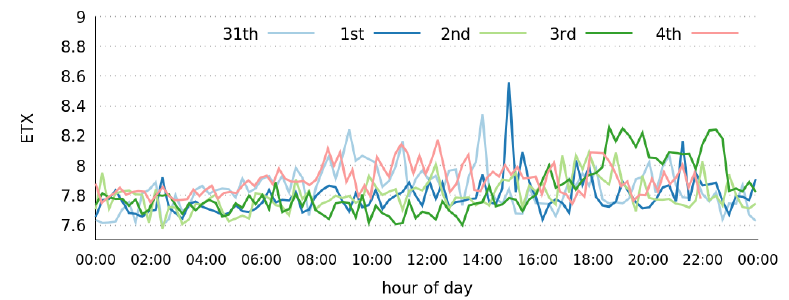
Figure 4. Temporal evolution of the average ETX of paths (working days).